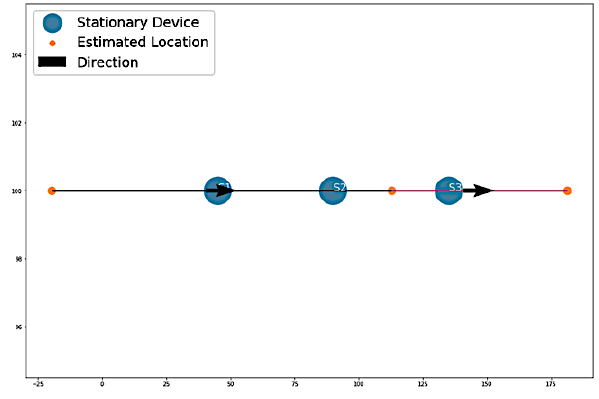
Figure 6. Algorithm 1’s estimation of the simulated path.